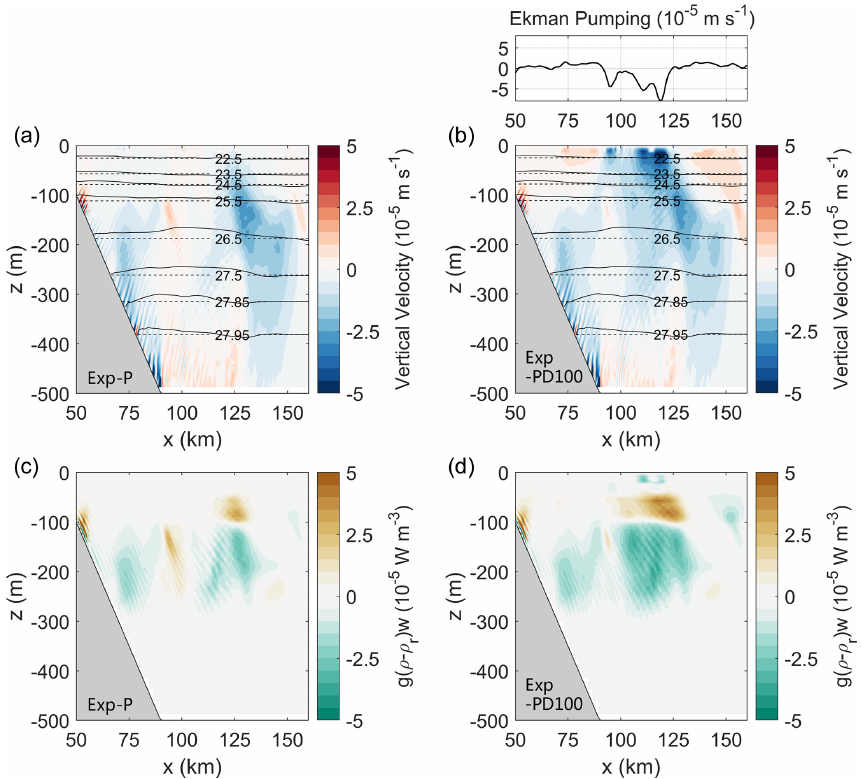
Figure 14. Vertical sections of (a, b) the vertical velocity (color) overlain by isopycnals (black solid contours) and (c, d) g(ρ − ρ r )w at t = 101d (see the location of the section in Fig. 13). The left column is from Exp-P and the right column is from Exp-PD100. The dashed black lines in (a) and (b) indicate the area-mean density profile. Above panel (b) is the Ekman pumping at t = 101d from